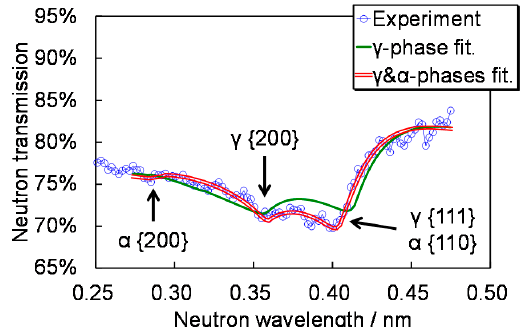
Figure 9. Bragg-edge transmission spectrum of the knife specimen and the RITS fitting curves assuming single-phase and double-phase [44]. The double phase assumption is suitable for reconstruction of the experimental data. This means this specimen consists of double phase ( α -Fe and γ -Fe).